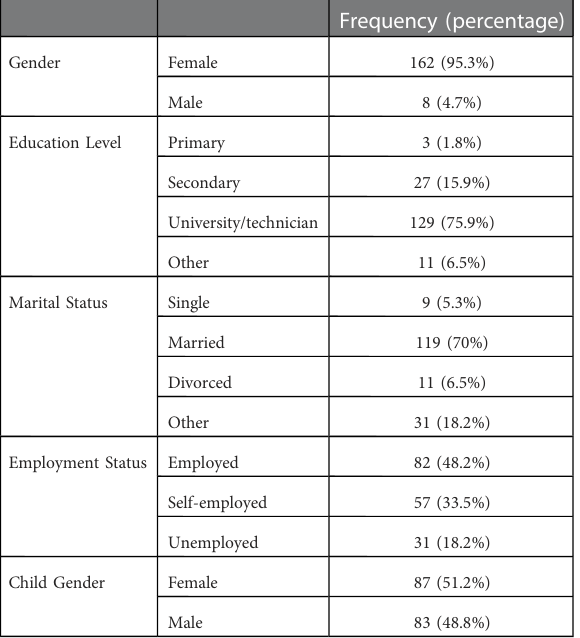
TABLE 1 Sociodemographic characteristics of baseline sample ( N =170).